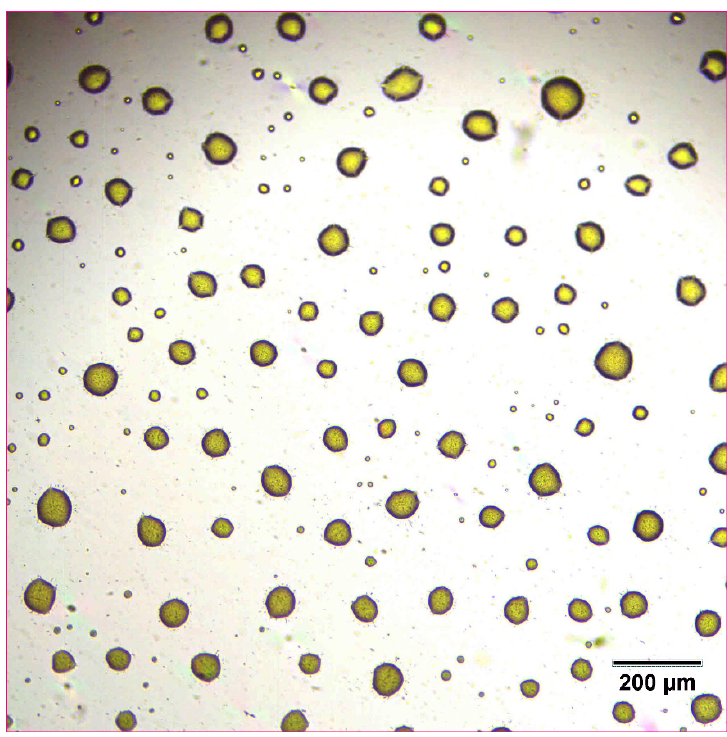
Figure 4. Optical microscope image of 10 mg/mL concentration naproxen nanosuspension after inkjet printing onto a film transparency at 100× magnification.